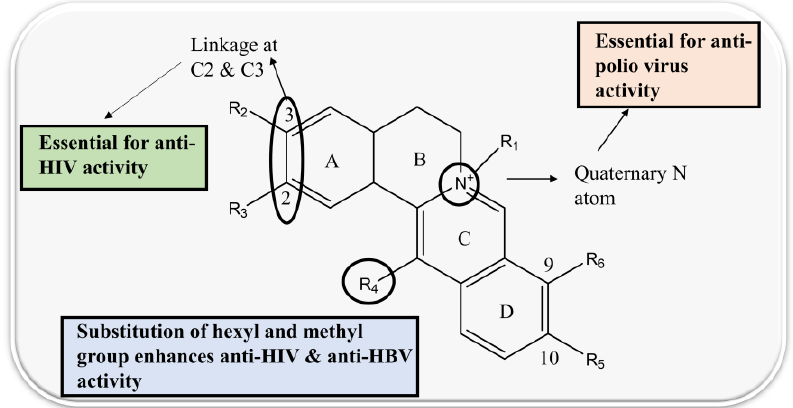
Figure 3. Structure – activity relationship of protoberberine